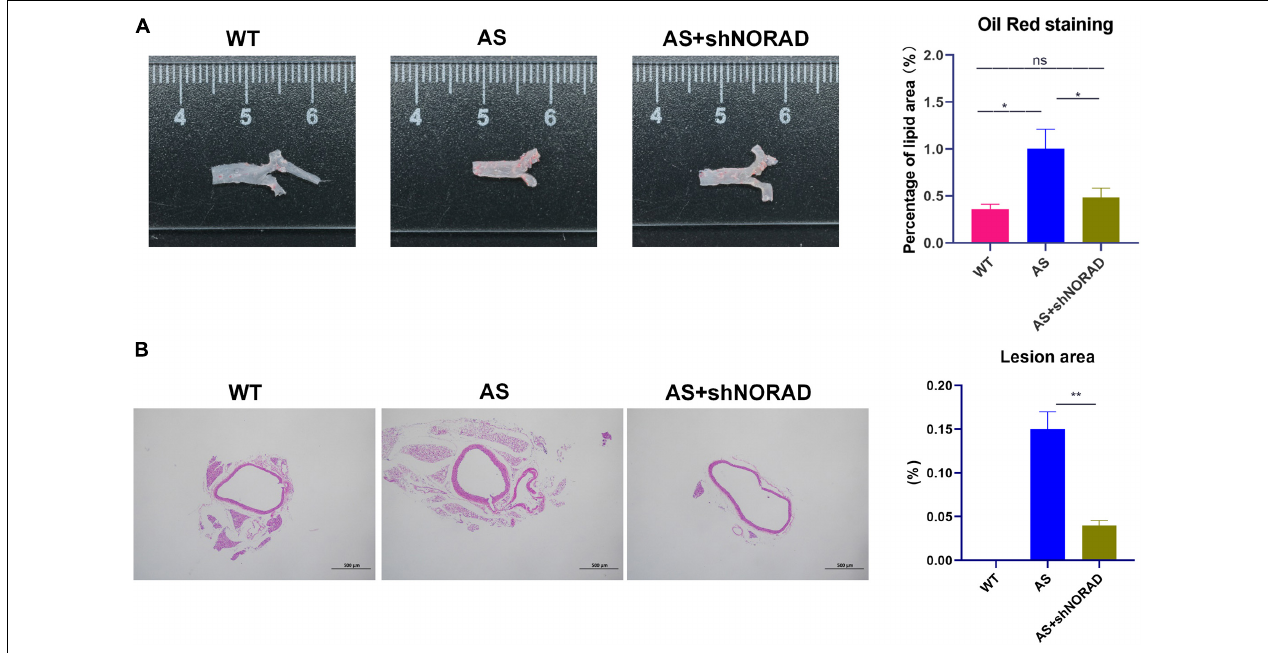
FIGURE 9 | Knockdown of lncRNA NORAD suppresses atherosclerosis development in atherosclerotic mice. (A) Representative images of the entire aorta with Oil Red O staining. Red indicated the atherosclerotic lesion areas. The bar graph showed the quantification of percentage of lipid area. (B) Representative images of aorta with H&E staining. The bar graph showed the quantification of lesion area in the aorta. WT, wild type; AS, atherosclerosis; shCtrl, control shRNA; shNORAD, shRNA-targeting lncRNA NORAD. N = 3. Bar = 500 µ m. * p < 0.05, ** p <